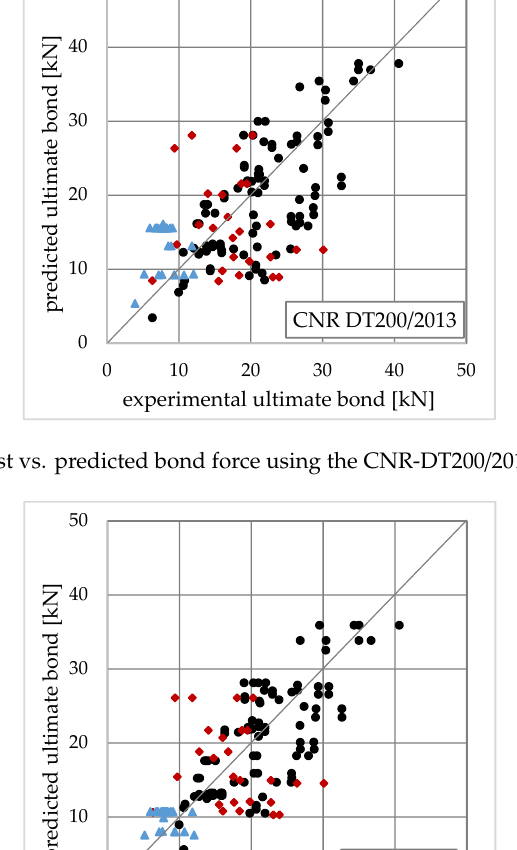
Figure 23. Test vs. predicted bond force using the SIA 166/2004 model [36]. Appl. Sci. 2020 , 10 , 8593